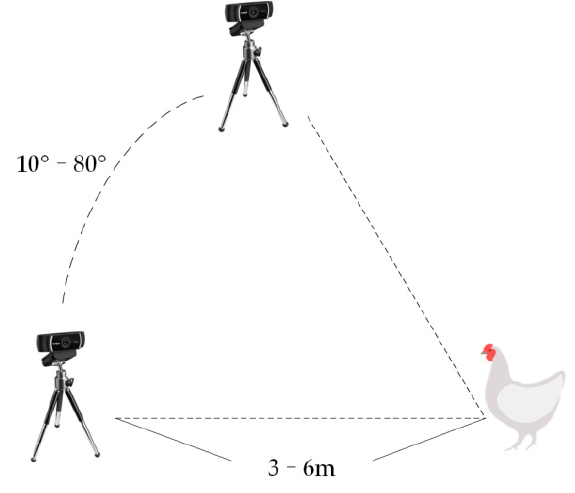
Figure 2. Photograph schematic.